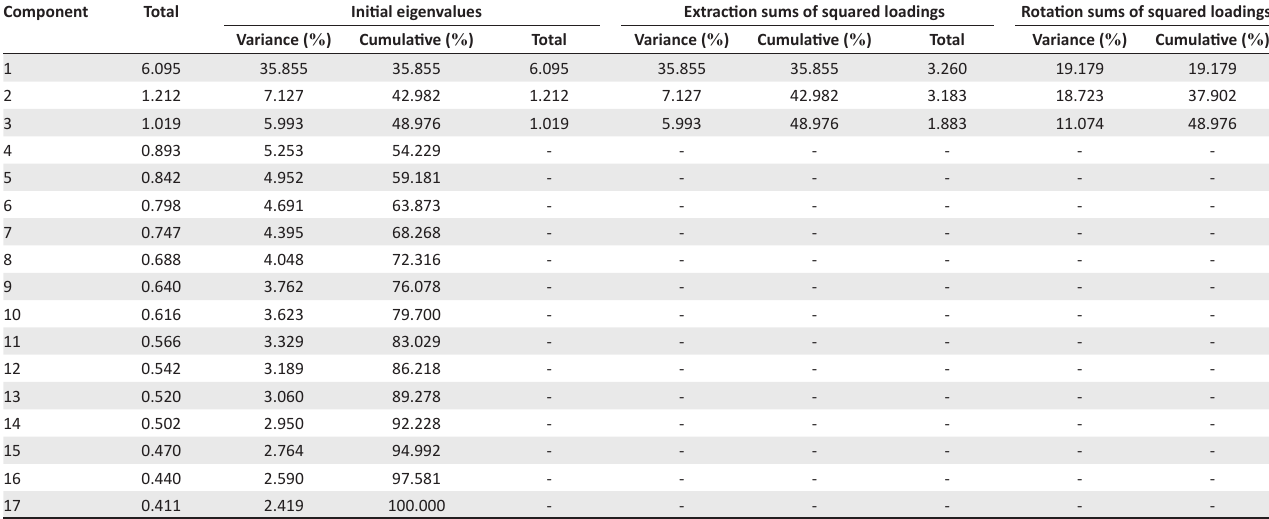
TABLE 1: Results of the principal component analysis on engagement in pre-Grade 1 activities, reported by the student’s parents or caregivers. Component Extraction sums of squared loadings Rotation sums of squared